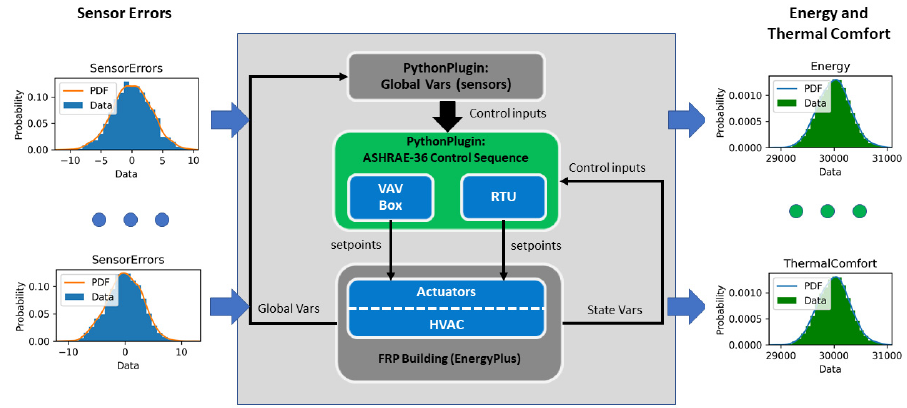
Figure 10. Uncertainty analysis process.